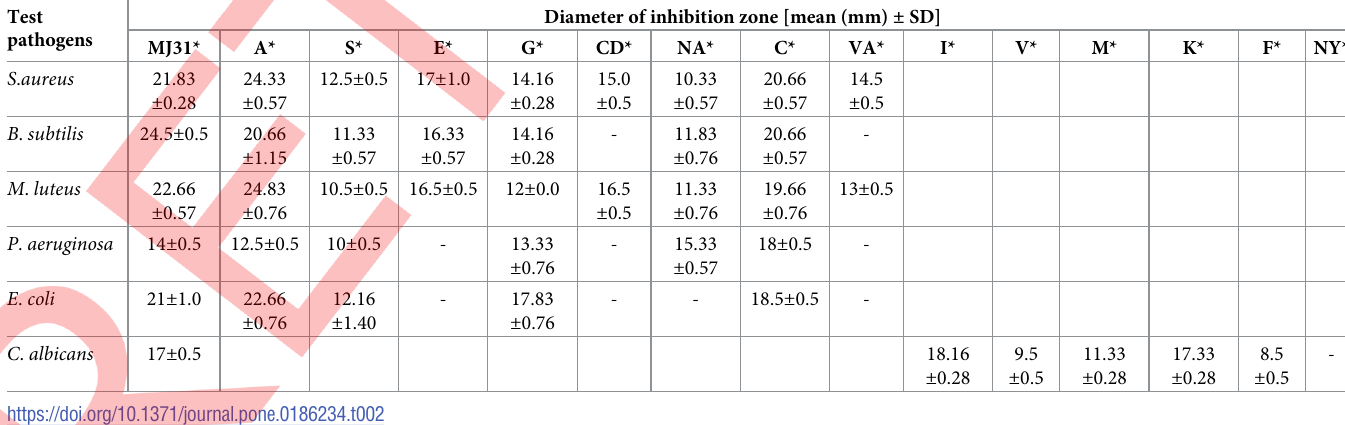
Detection and quantification of antibiotics using UPLC-MRM method Analytical method validation. The proposed UPLC-MRM method for quantitative anal- ysis was validated according to the guidelines of international conference on harmonization (ICH, Q R ) by linearity, LOQs and LODs, precision, solution stability and recovery. 2 1 Linearity, limits of detection (LOD) and quantification (LOQ). A series of concentra- tions of standard solution were prepared for the establishing calibration curves. The peak areas were plotted against the corresponding concentrations to obtain the calibration curves. LOD and LOQ were determined by calibration curve method. LOD and LOQ were calculated by using following equations. LOD = (3.3 × Sy.x)/S; LOQ = (10 × Sy.x)/S (Where, Sy.x is standard deviation of residuals from line; S is slope). The results were listed in Table 4. All the calibra- tion curves indicated good linearity with correlation coefficients (r 2 ) from 0.9989 to 0.9999 Table 2. Antibacterial and antiyeast activity of endophytic fungus Aspergillus clavatonanicus strain MJ31 against human pathogens. Test